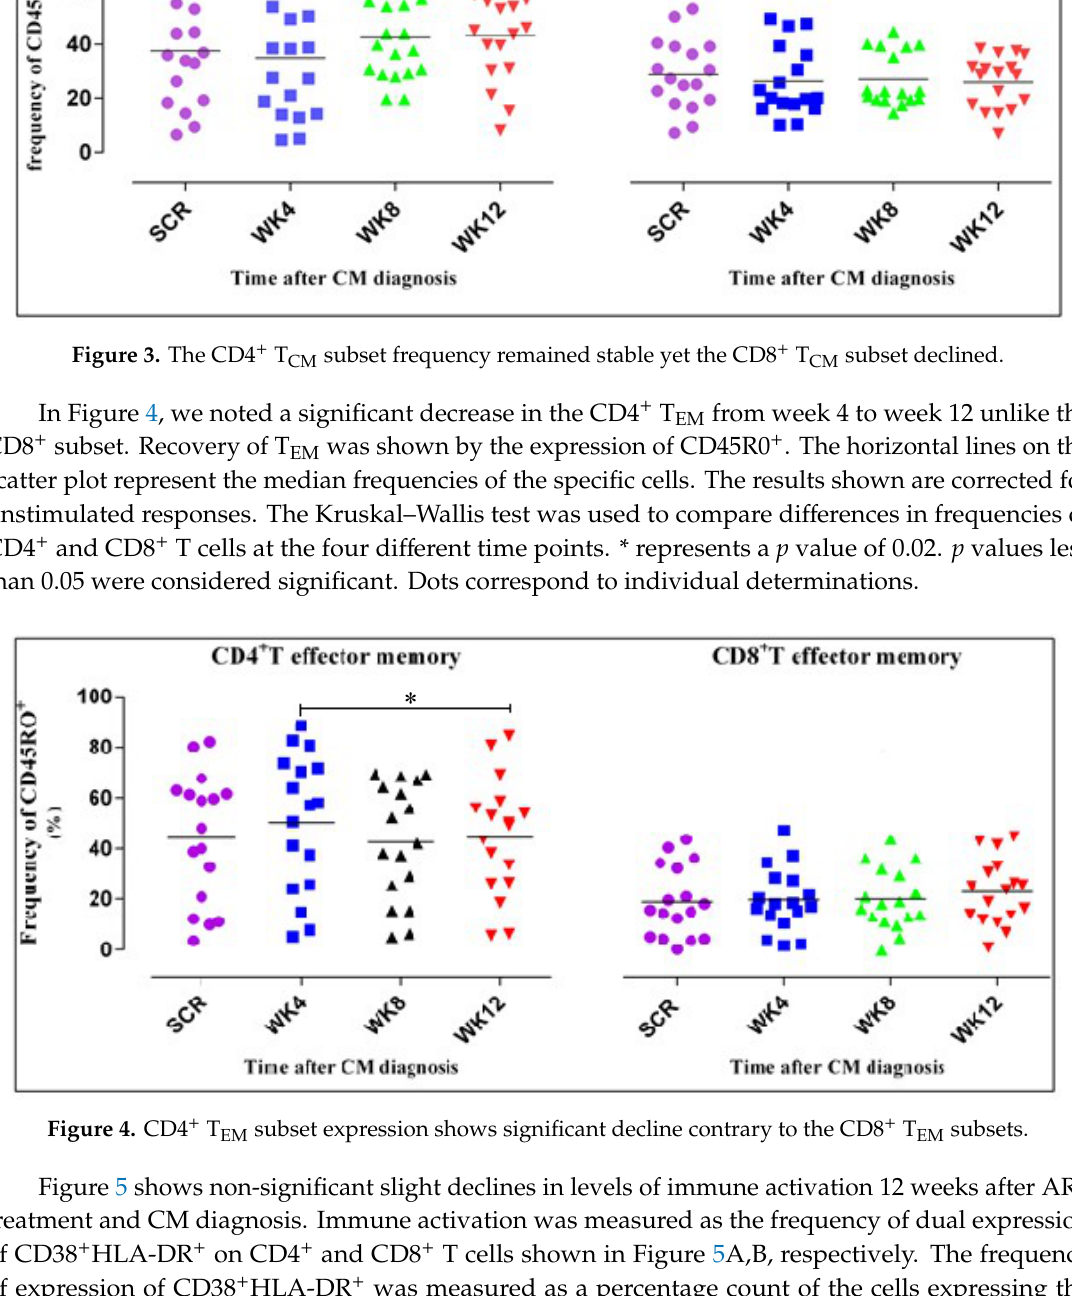
Figure 4. CD4 + T EM subset expression shows significant decline contrary to the CD8 + T EM subsets.